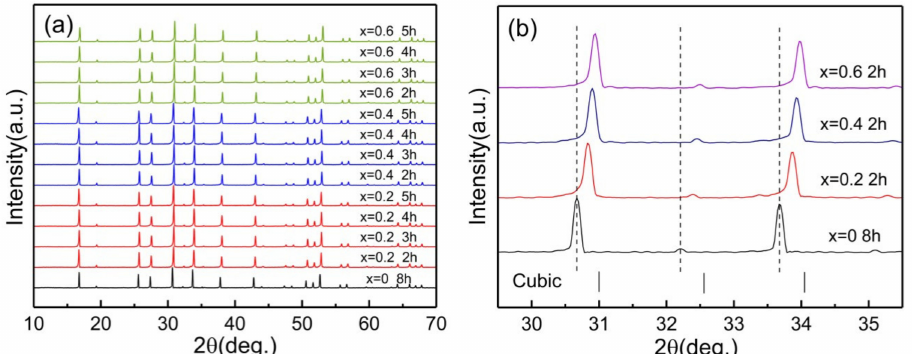
Figure 2. ( a ) XRD patterns of LLZN x O (x = 0, 0.2, 0.4, 0.6) ceramics sintered at 1250 ◦ C for different times. ( b ) The enlarged XRD patterns of LLZN x O (x = 0, 0.2, 0.4, 0.6) ceramics sintered at 1250 ◦ C for 2 h from 29.5 to 35.5 ◦